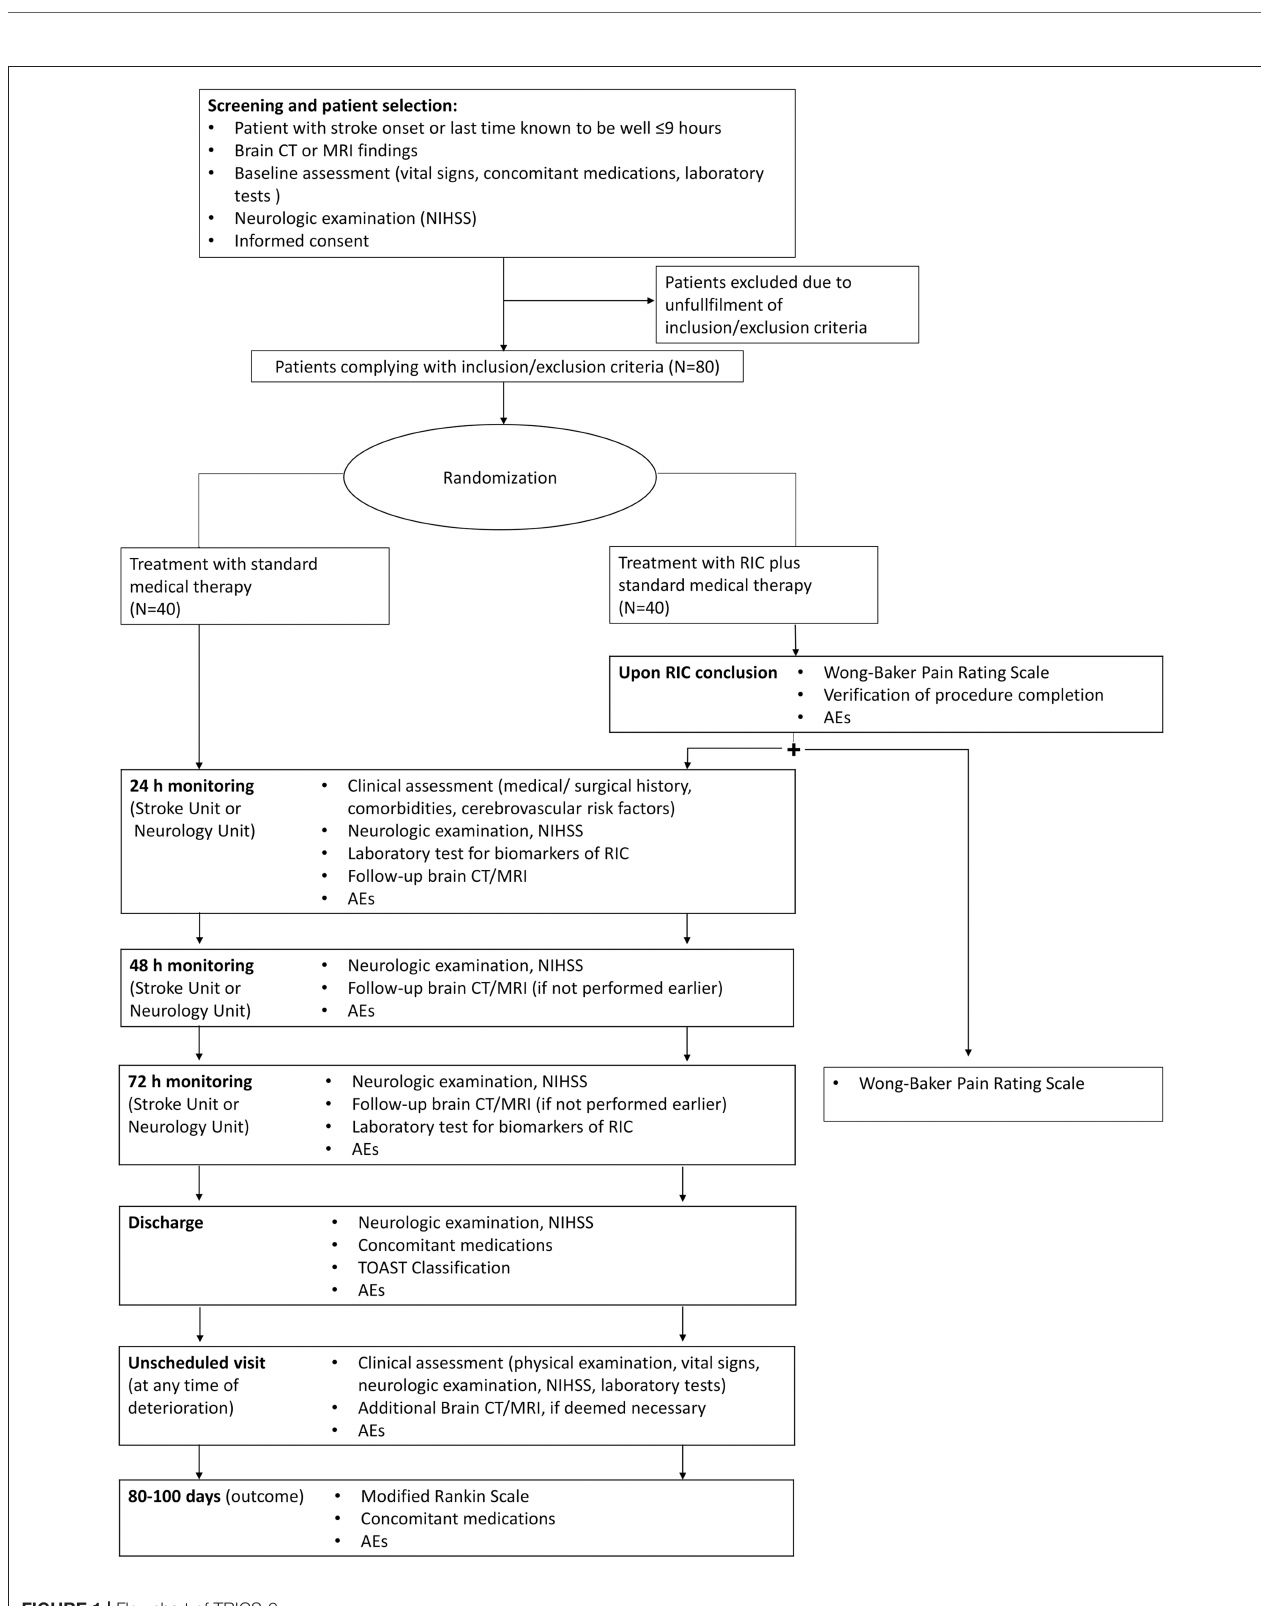
FIGURE 1 | Flowchart of